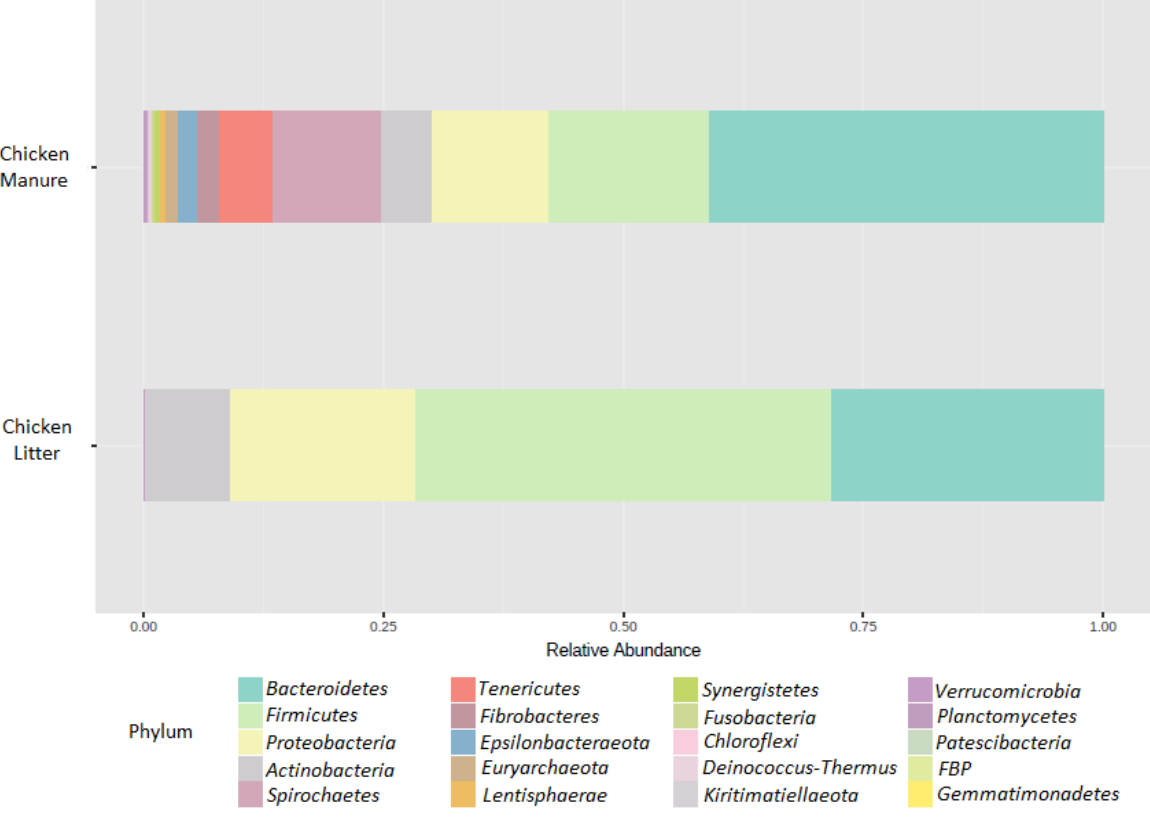
Figure 2. Microbial composition of collected feces samples at the phylum level. The visualization represents the mean value for three replicates.